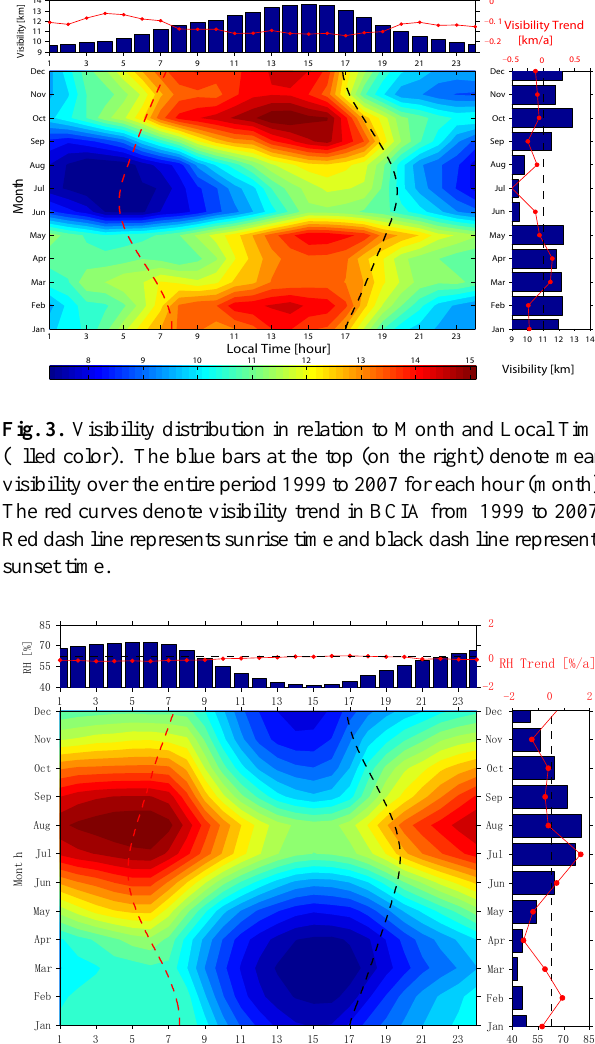
Table 1. The relationships between API and PM 10 concentration.